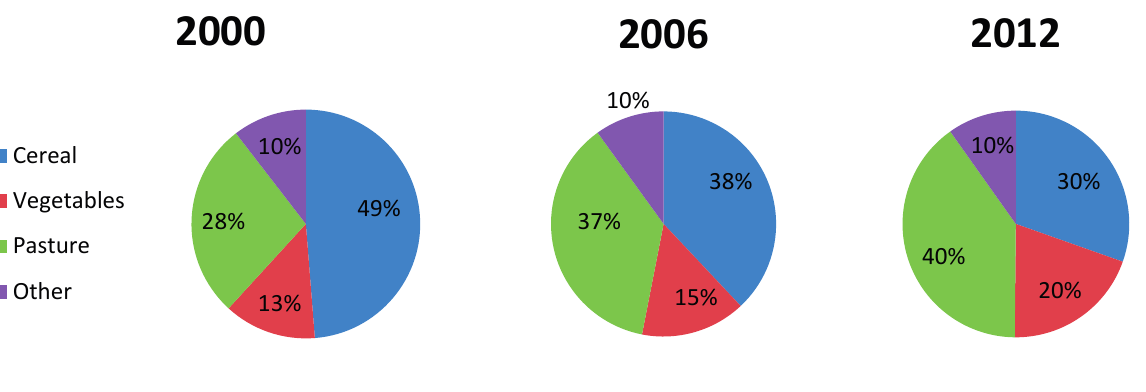
Figure 5. Use of agriculture area in Lier municipality in year 2000, 2006 and 2012 (based on numbers from Statistics Norway